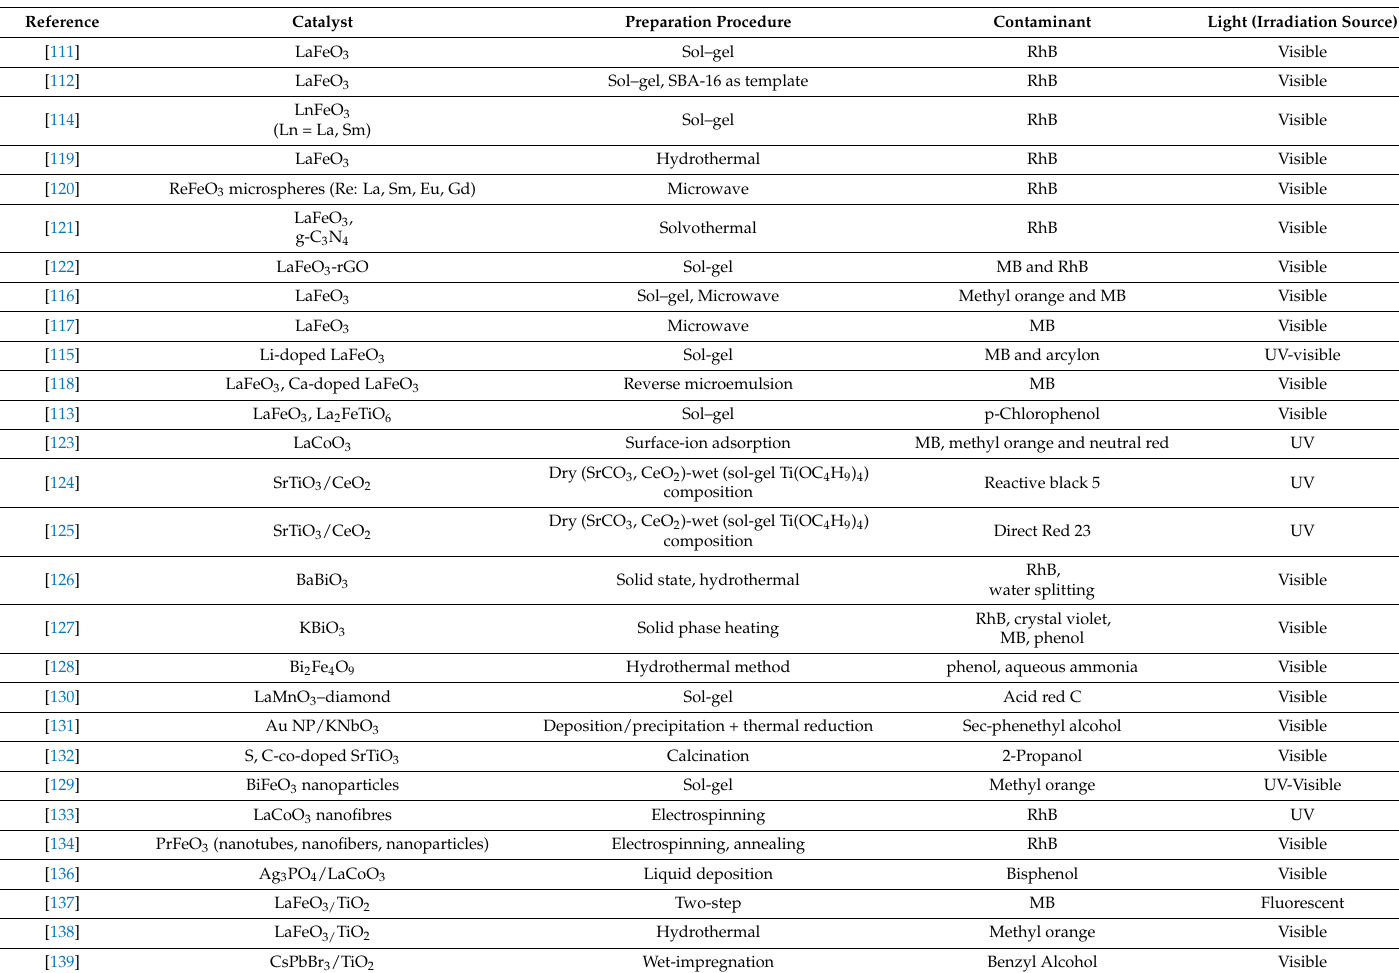
Table 3. Oxides type perovskite applied as photocatalysts for the degradation of different organic contaminants in aqueous